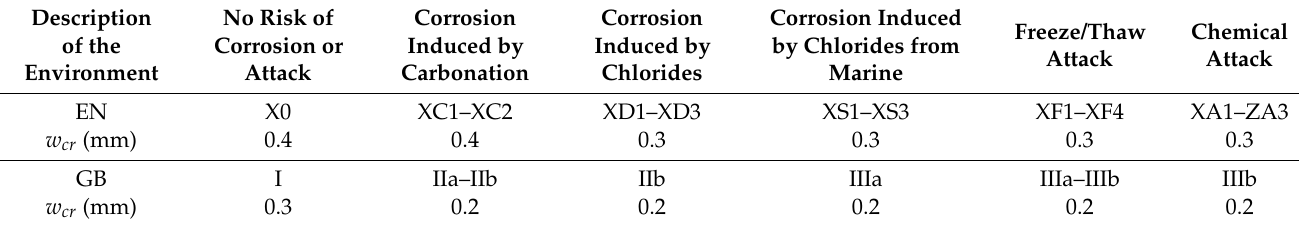
Table 2. Exposure classes related to environment conditions and the maximum allowable crack